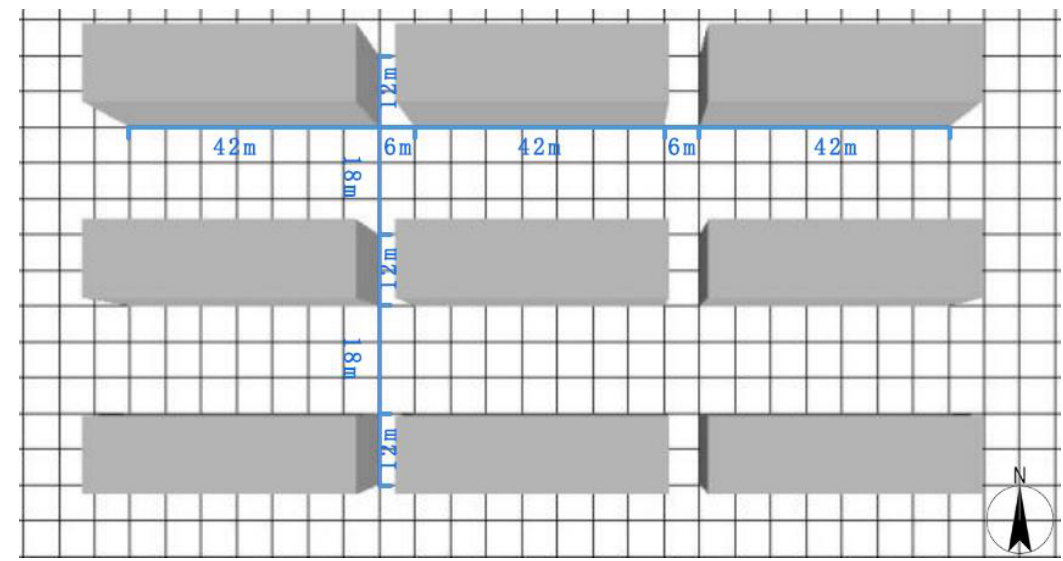
Figure 1. The typical residential unit in southern Hunan.